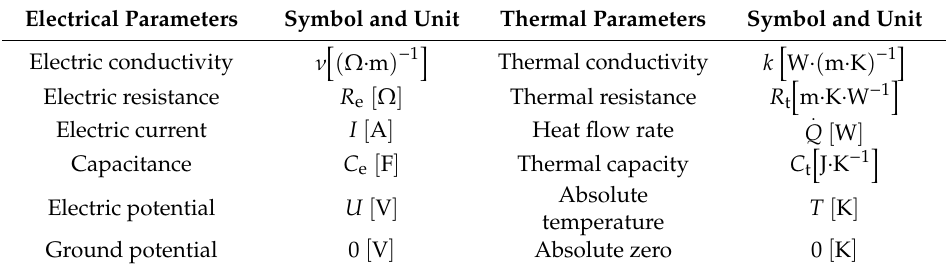
Table 1. Electrothermal